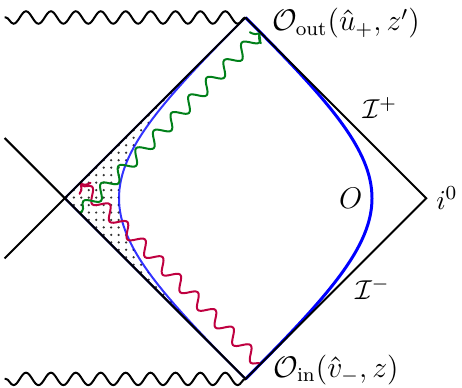
Figure 6. The commutator between an operator O in (ˆ v − , z ) creating an early infalling mode and an operator O (ˆ u 0 ) measuring a late outgoing mode exhibits Lyapunov growth due to out + , z exponentially growing collision energy between the modes near the horizon. This commutator is generated via the coordinate shifts (2.46) and (2.47) and the commutator (2.35) between the late and early Goldstone modes ˆ f and ˆ f + −